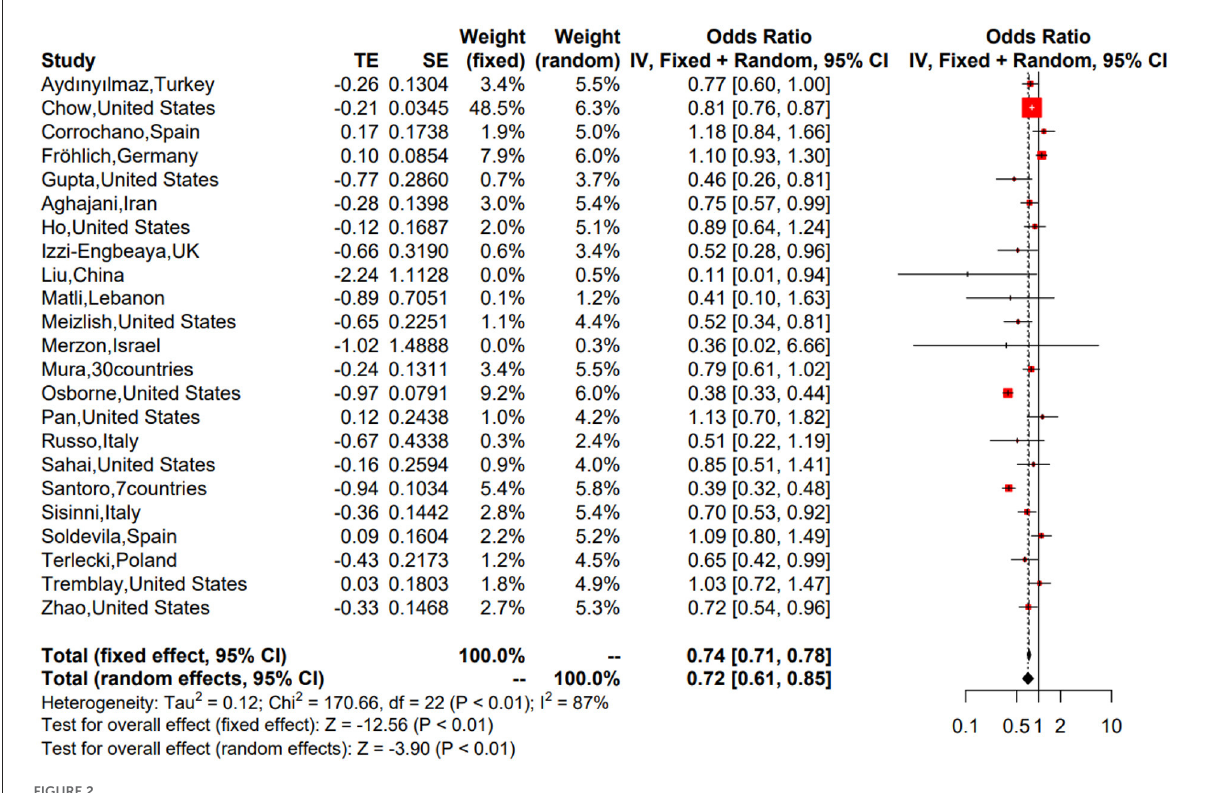
FIGURE2 Forest plot of the 23 included observational